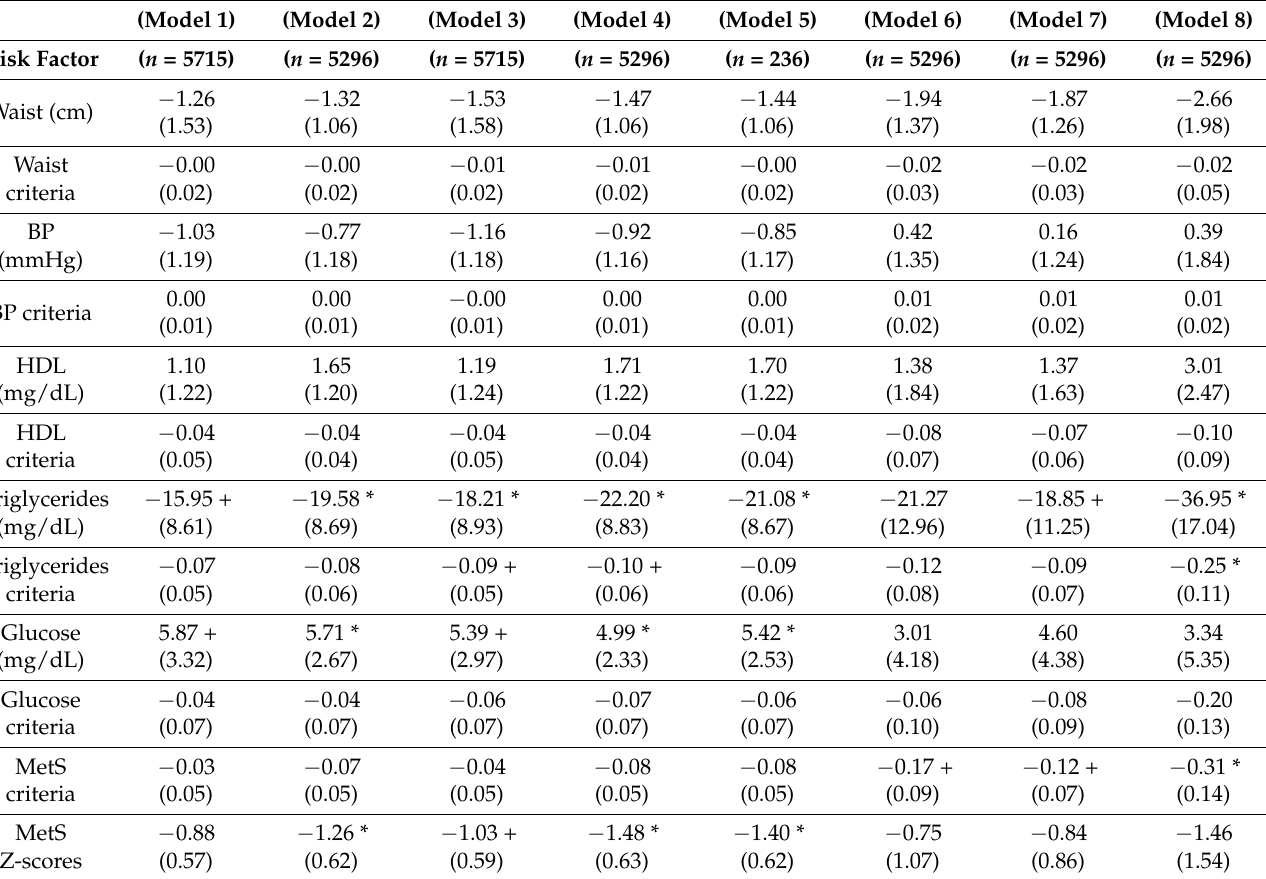
Table A3. Estimated effect of SNAP eligibility on cardiometabolic risk factors in children and adolescents between the ages of 2 and 18 years: narrow bandwidth across functional